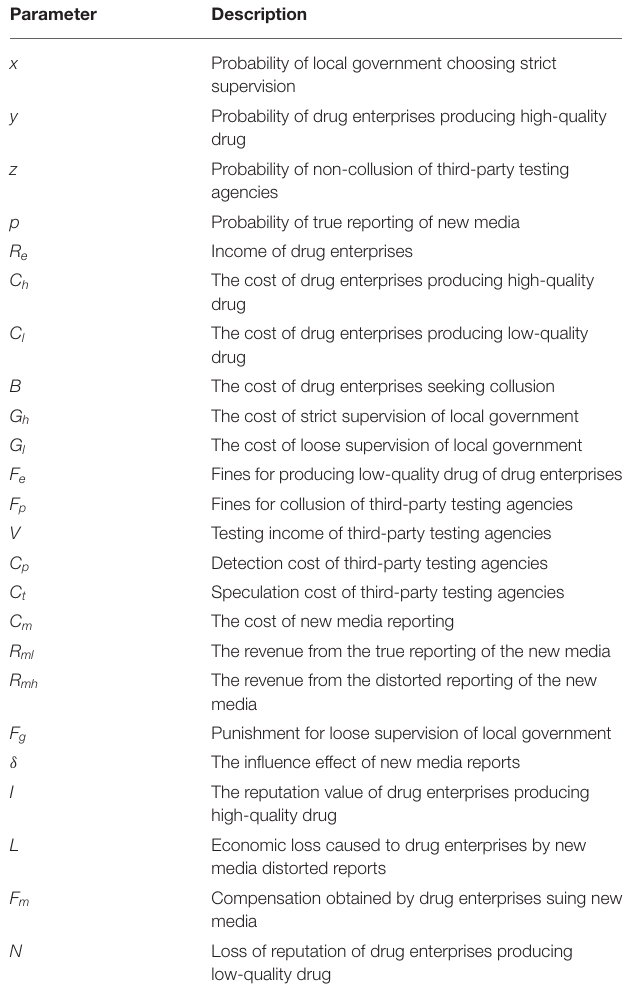
TABLE 1 | Related parameter